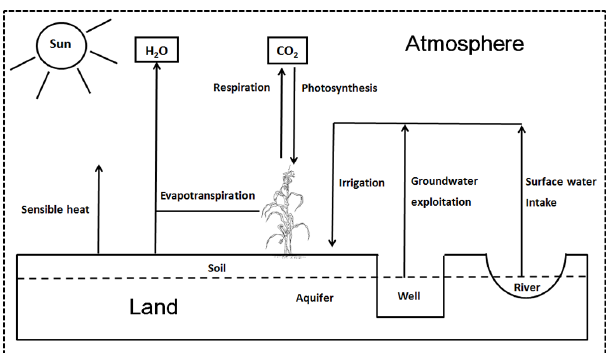
Figure 2. Diagram of the irrigation module showing how irrigated water impacts land–atmosphere